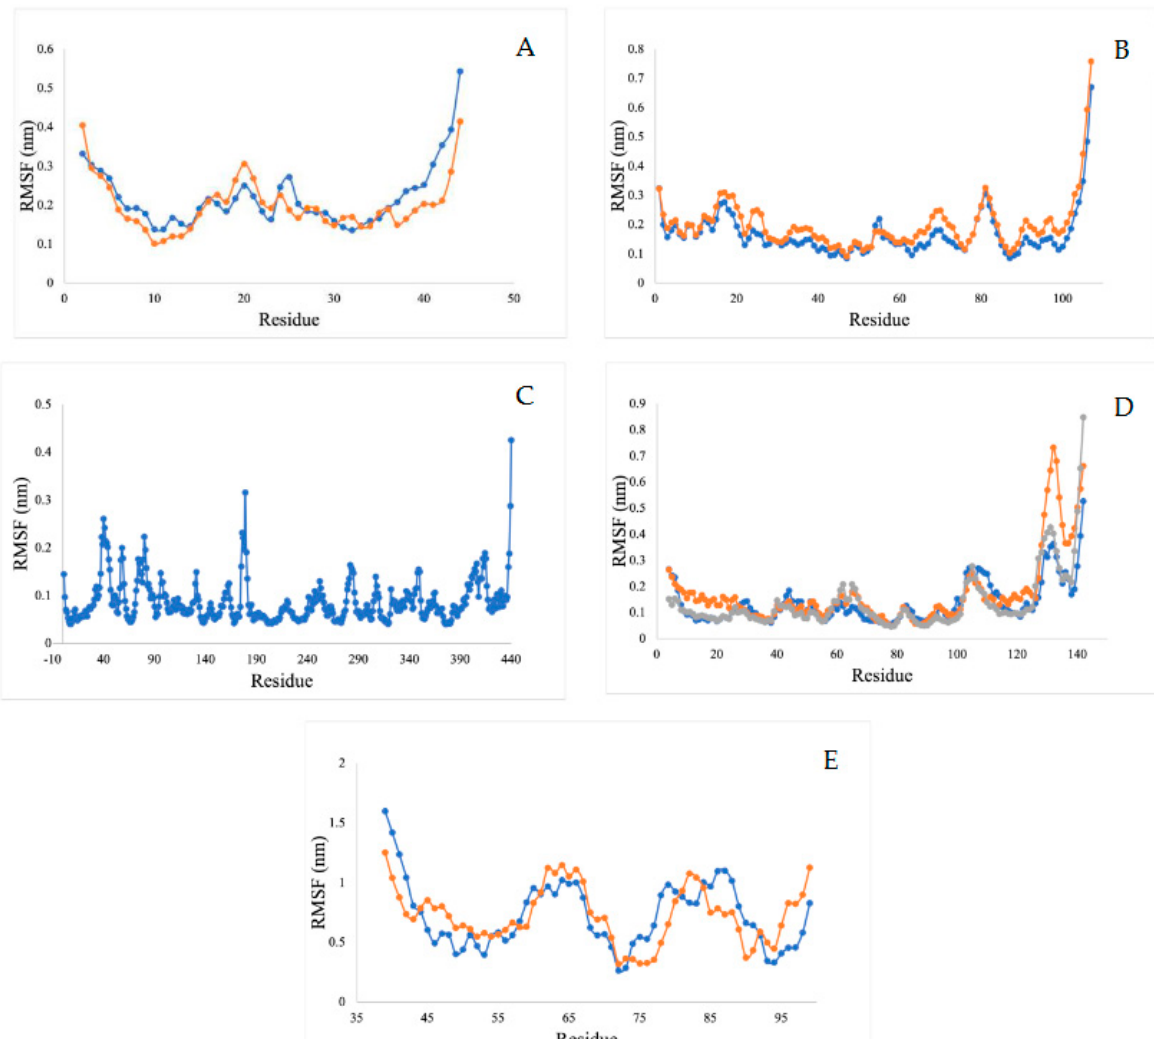
Figure 13. RMSF analysis for ( A ) acetylcholine esterase, ( B ) actin, ( C ) Α -tubulin, ( D ) arginine kinase, and ( E ) histone subunit III with inhibitors (disodium 5 ′ -inosinate and petunidin 3-glucoside), (calcium 5 ′ -guanylate D and chlorogenic acid), chlorogenic acid, (kaempferol-3,7-di-o-glucoside I, hyperoside D, delphinidin 3-glucoside ID), and (myricetin 3 ′ -glucoside ID, hyperoside D) complexes.